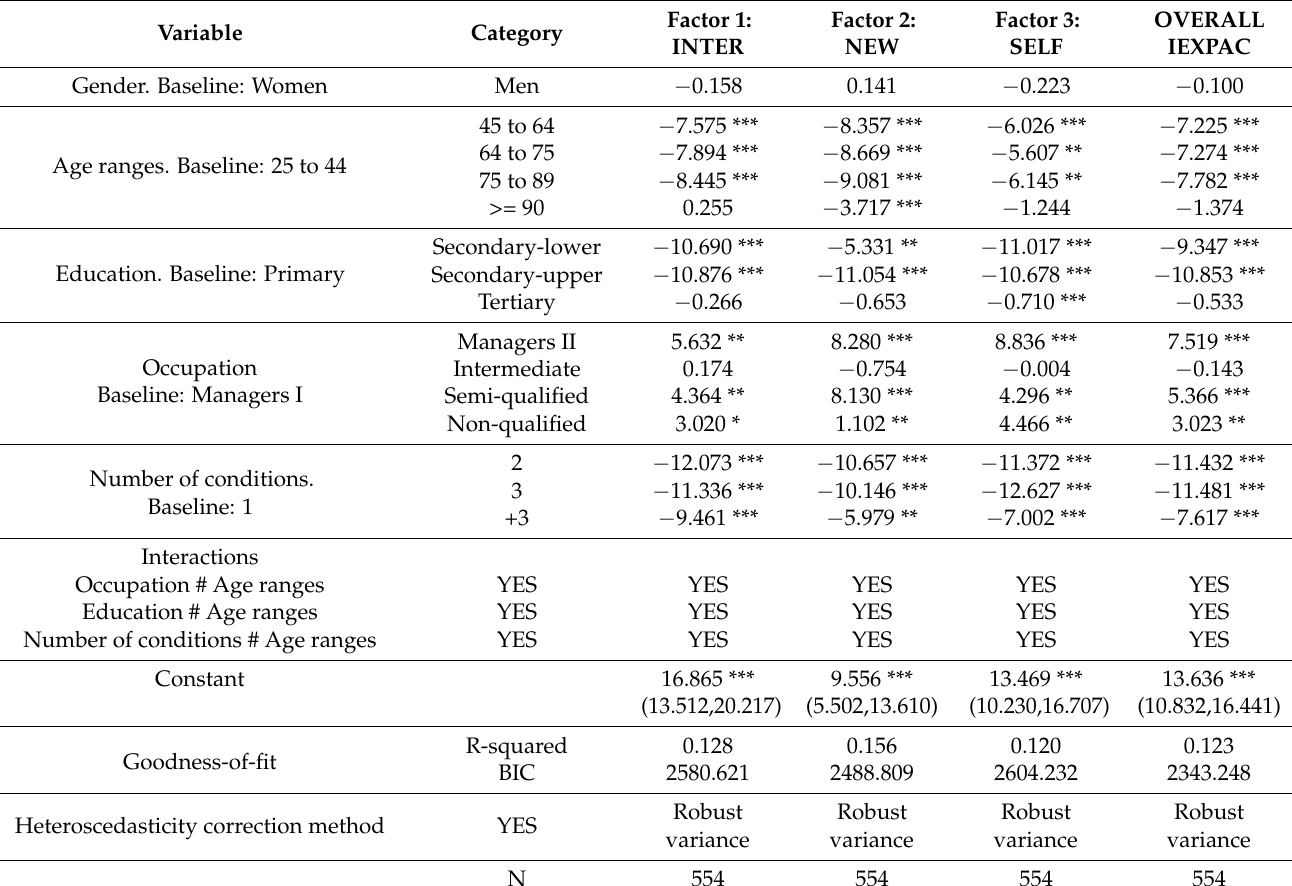
Table 5. Model 3—WLS results. Differences in healthcare experience among patients with diabetes. The effect of the presence of